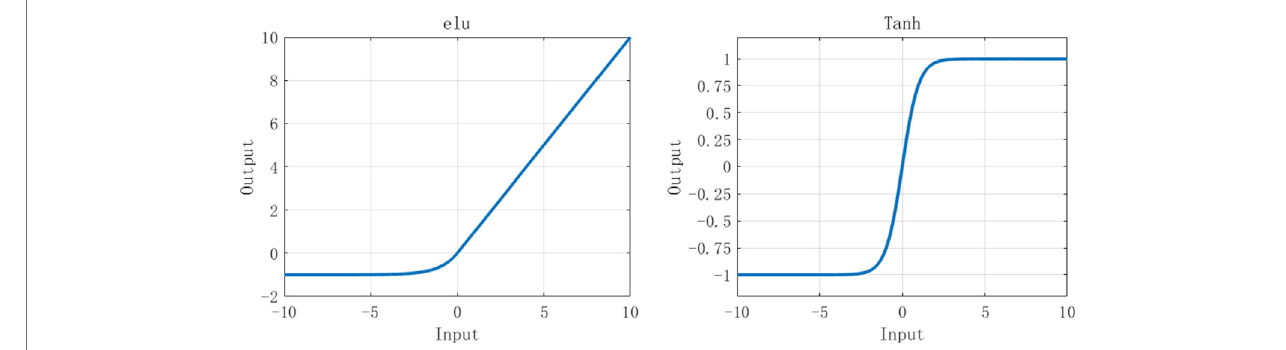
FIGURE 1 | Graphs for tanh and elu.